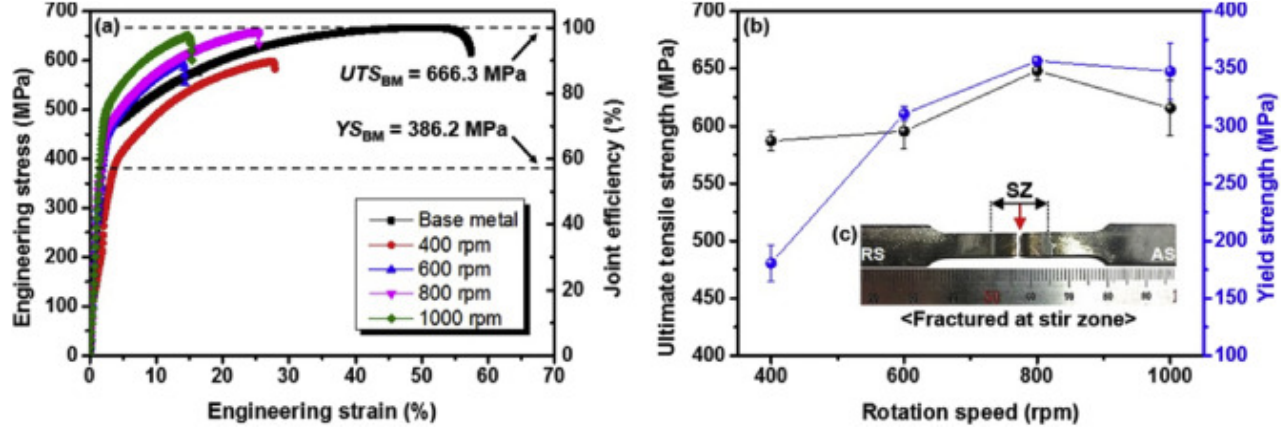
Figure 14. Tensile properties of the FSWed HEA ( a ) stress-strain curve, ( b ) UTS and YS of the joints (c) tensile specimen. Reproduced with permission from [101], Copyright Elsevier, 2019.